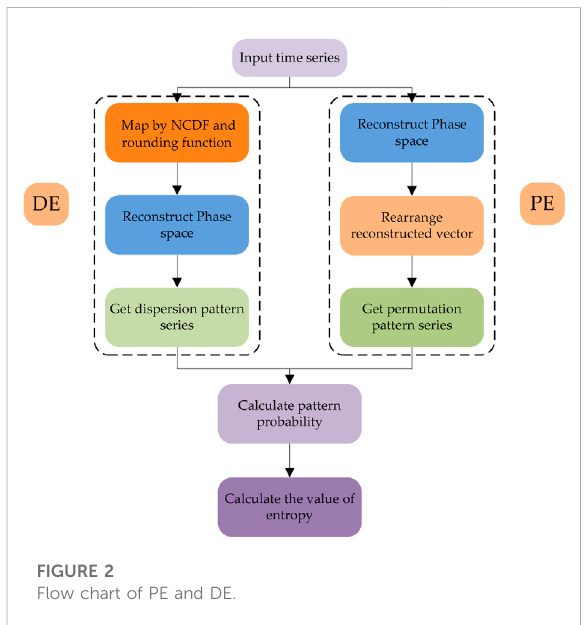
FIGURE 2 Flow chart of PE and